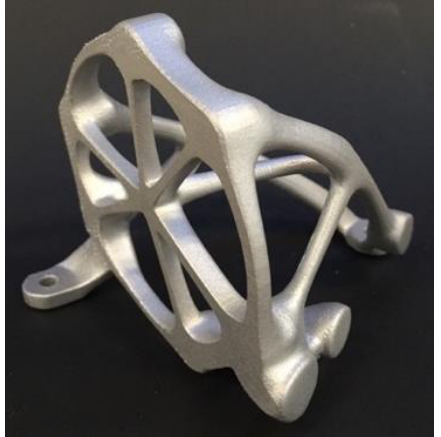
Figure 10. AM fabricated camera star bracket.